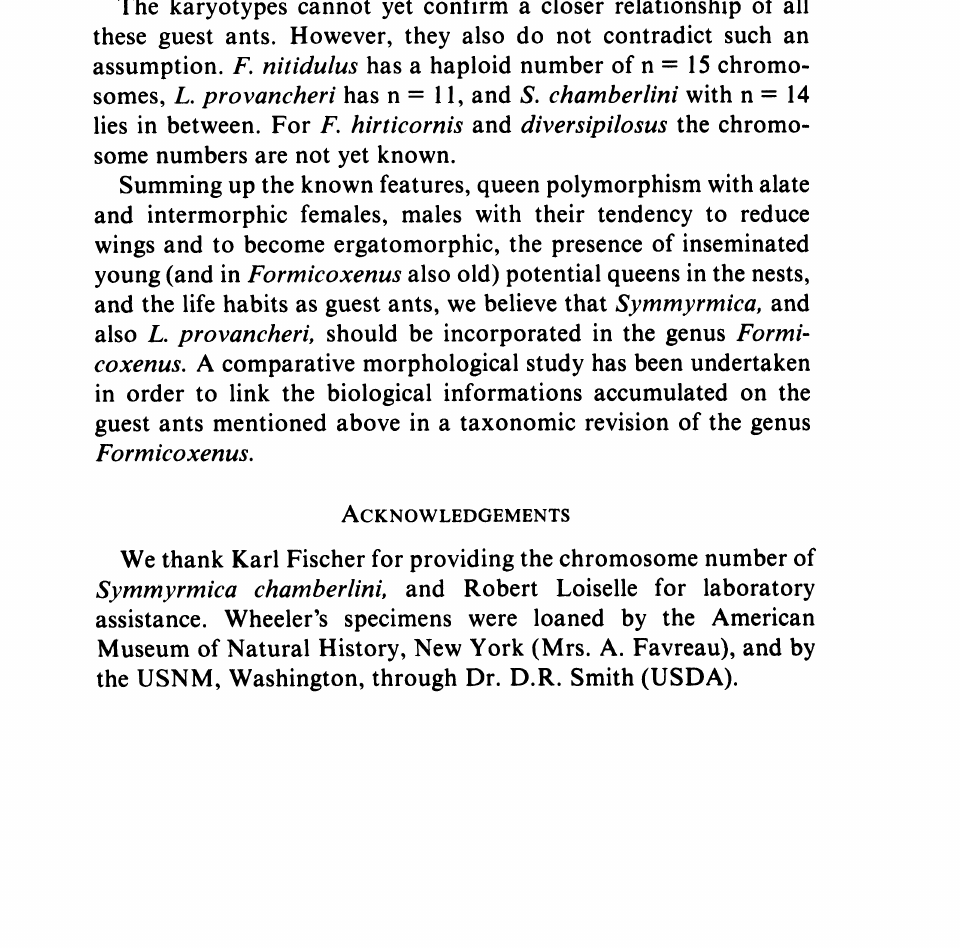
Table 2. Types of S. chamberlini intermorphs according to Plateaux’ classification of Leptothorax nylanderi. Source Form 2 Form 3 Form 4 Form 6-7 Total examined Wheeler (1904) 0 5 0 6 Colony no. 3 4 2 +) 10 Colony no. 2 7 0 13 2 ++) 22 Colony no. 3 2